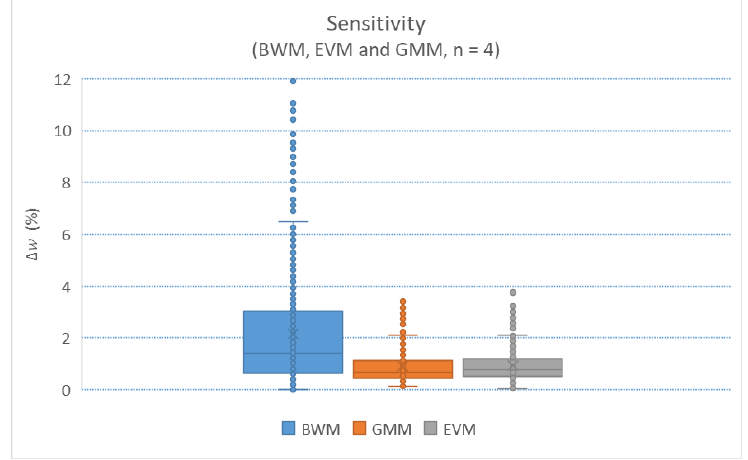
Figure 3. Mean sensitivity: BWM adjusted, EVM, and GMM.